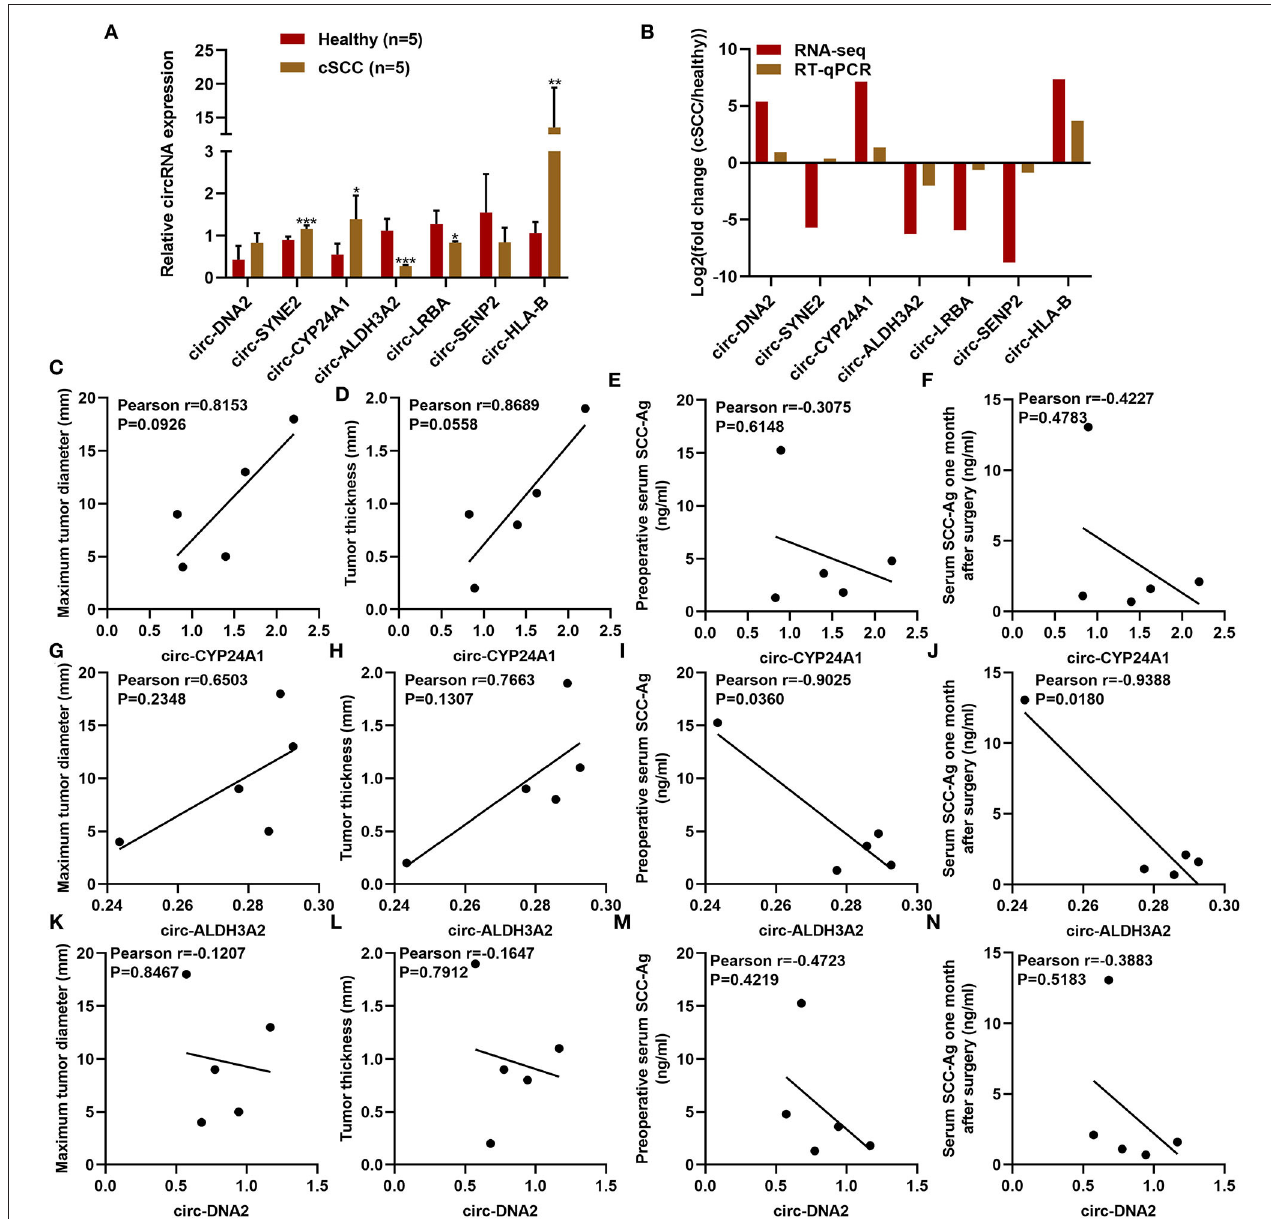
FIGURE 4 | Clinical characteristics of differentially expressed circRNAs in cSCC. (A,B) RT-qPCR for validation of the expression of plasma circ-DNA2, circ-SYNE2, circ-CYP24A1, circ-ALDH3A2, circ-LRBA, circ-SENP2, and circ-HLA-B in 5 paired cSCC and healthy individuals. (C-N) The correlations of plasma (C-F) circ-CYP24A1, (G-J) circ-ALDH3A2, and (K-N) circ-DNA2 levels with maximum tumor diameter, tumor thickness, pre-operative serum SCC-Ag and serum SCC-Ag 1 month after surgery. * P -value < 0.05; ** p -value < 0.01; *** p -value < 0.001.